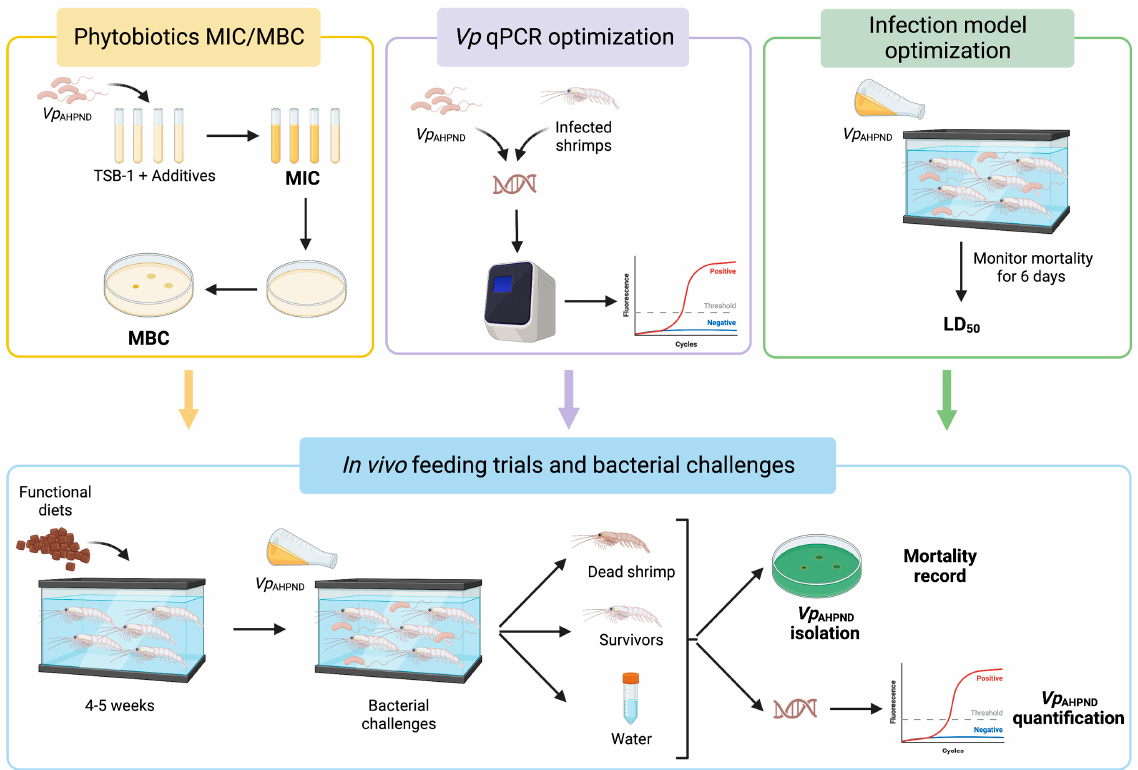
Figure 1. Overview of the experimental design of this study. Created with